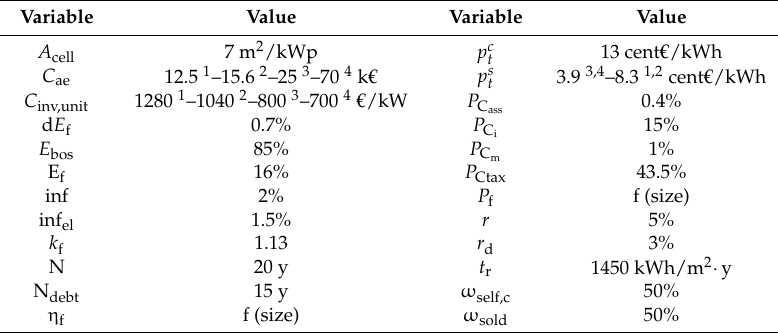
Table 2. Economic and technical input data-sources: